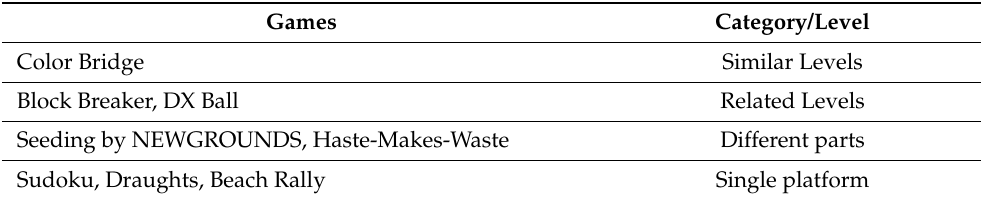
Table 1. Mapping of existing games with categories of taxonomy.